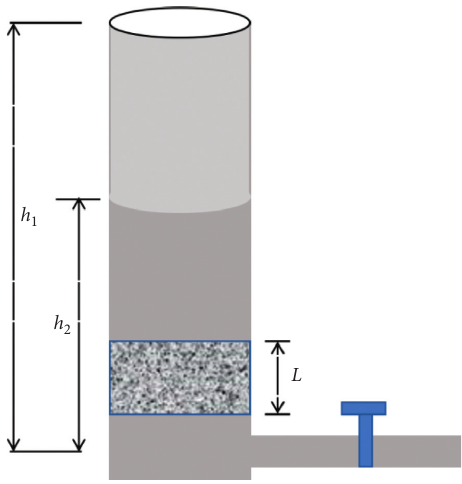
Figure 5: Falling head permeability